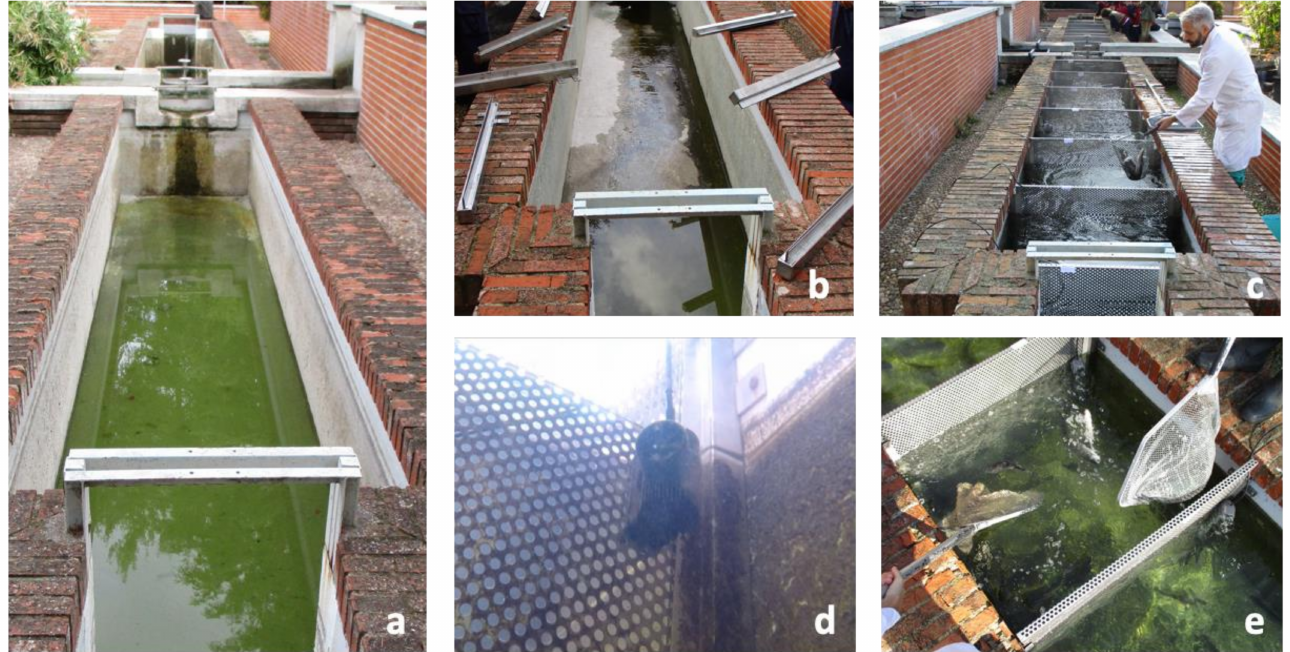
Figure 1. Different aspects of the adaptation and operation of the tanks for the study: ( a ) overview of the complete raceway before the study; ( b ) adaptation of the tank sections; ( c ) image of the raceway with separations with tanks; ( d ) underwater image of one of the water pumps used for generating under water currents; and ( e ) image of one